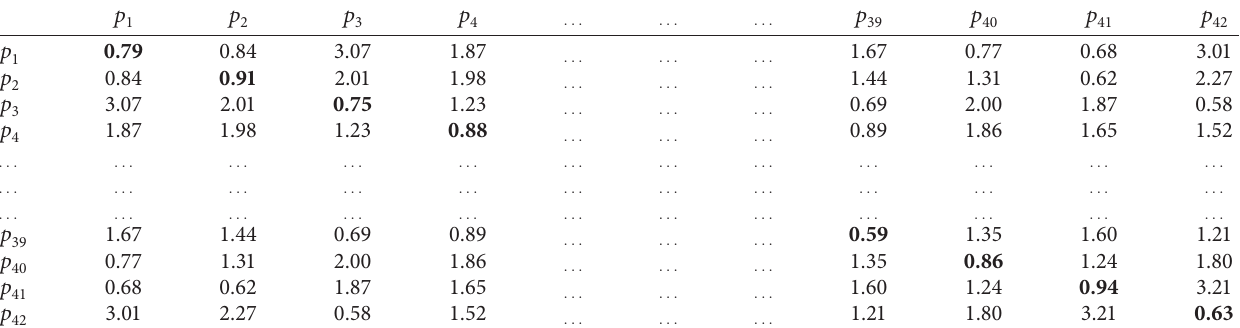
Table 9: Individual knowledge competence and knowledge